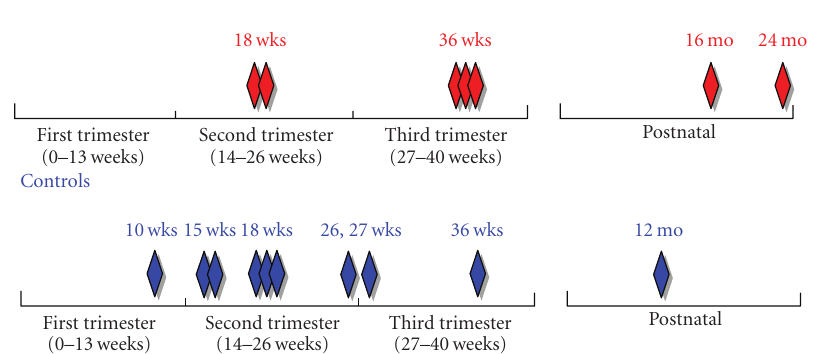
Figure 1: Gestational and postnatal ages of the obstructed and control kidney tissue